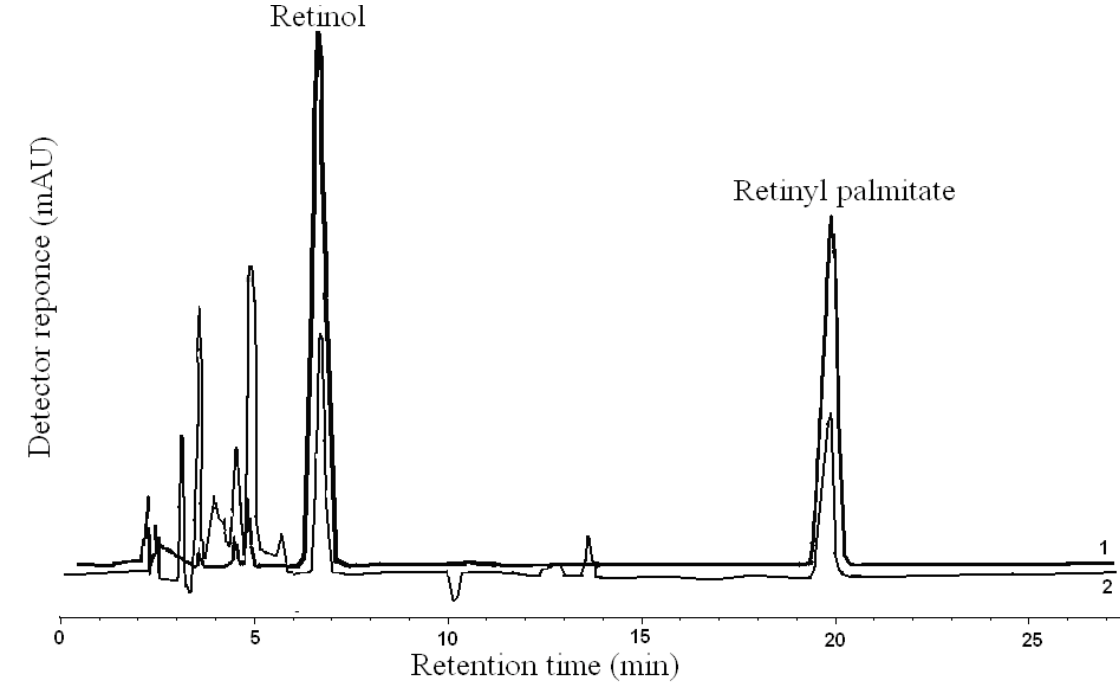
Figure 1. Isocratic elution was performed with methanol-acetonitrile-tetrahydrofuran (65:30:5, v/v/v) as mobile phase at a flow rate of 1.5 mL min -1 , 40 0 C. Inertsil ODS3 reversed phase column (250×4.6 mm 5 µm) was employed. DAD was adjusted at 325 nm. Chromatogram of vitamins: (1) standard of retinol and retinyl palmitate in the mobile phase; (2) retinol and retinyl palmitate the extracted from rat